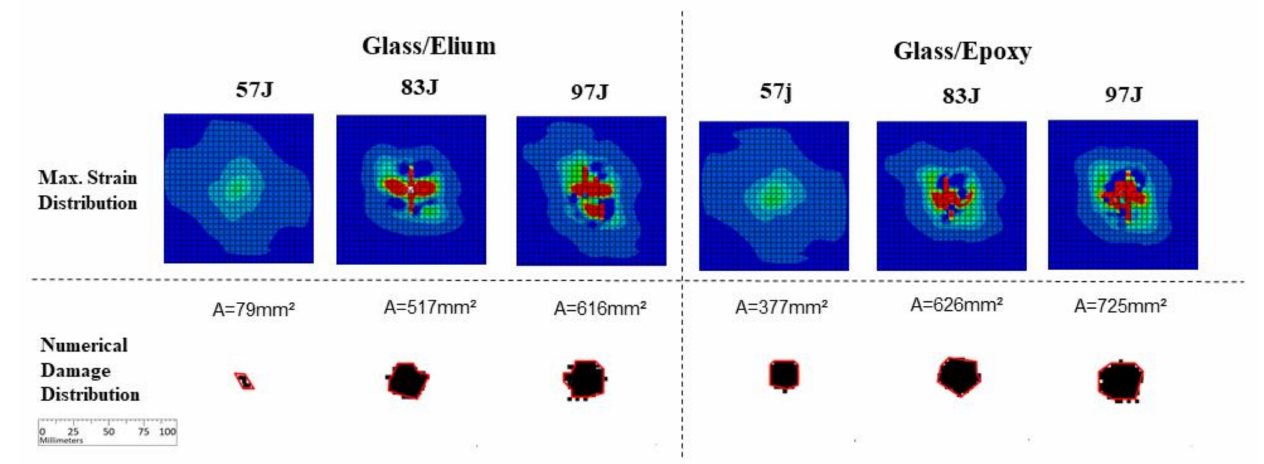
Figure 18. Numerical results for glass fiber specimens.